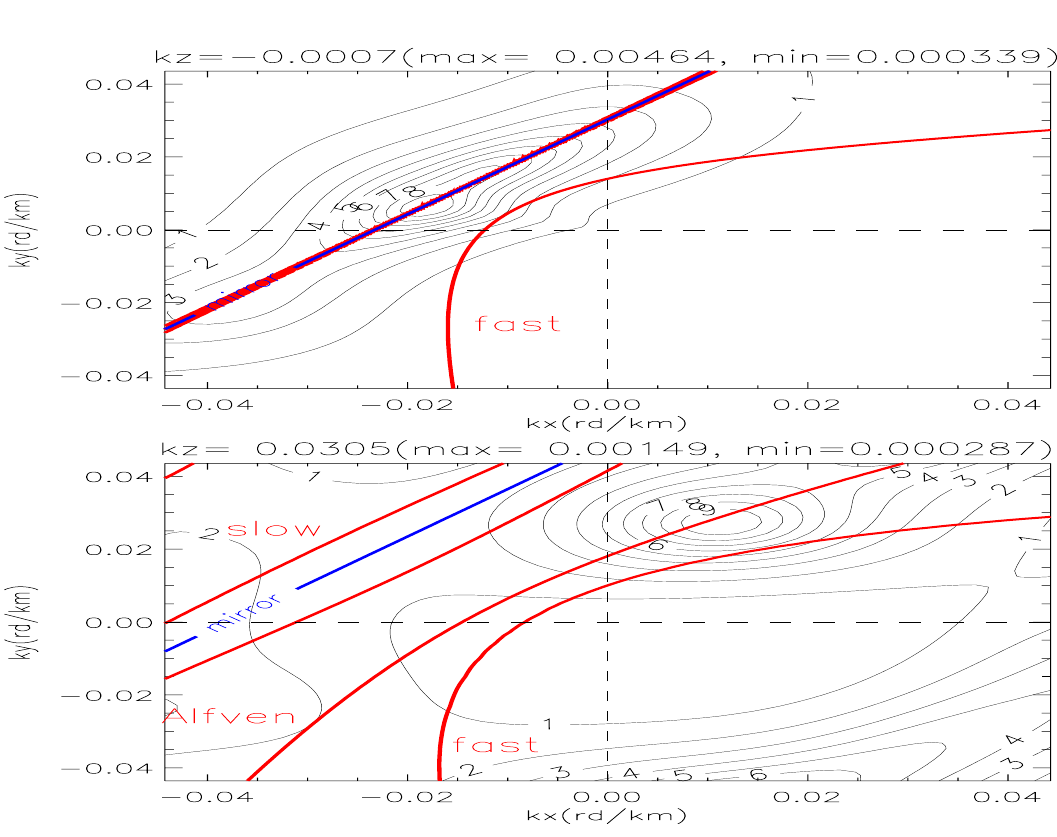
Fig. 5. Superposition of the experimental magnetic energy (thin black lines) with the theoretical dispersion relations of the LF modes (colored thick lines) in the satellite frame for the frequency 0 . 61Hz. The blue line is the Doppler shift ω = k . v . Two main peaks are identified: a mirror mode (top panel) and a cyclotron harmonic mode ( f plasma = 0 . 71Hz ∼ 2 f ci ), which seems to have a dispersion close to the classical MHD Alfv´en mode (bottom